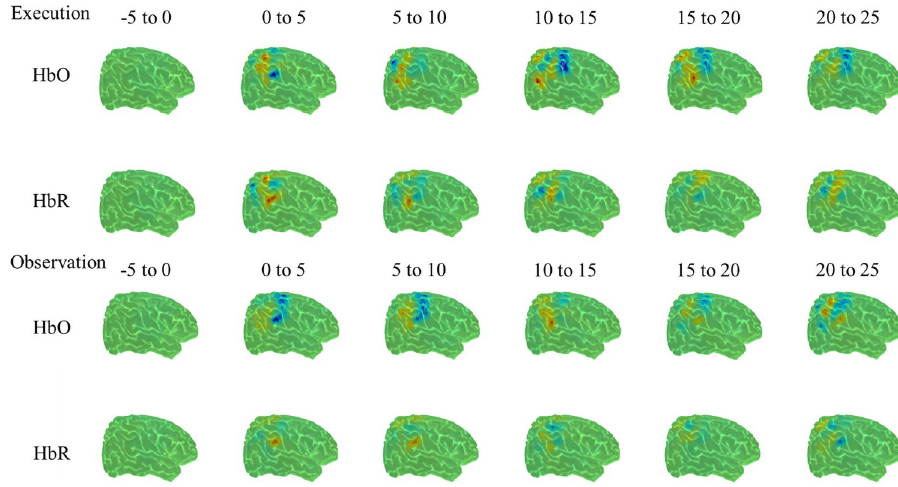
Fig 4. HbO and HbR reconstruction maps for execution and observation in the right hemisphere from -5 to 25 seconds.